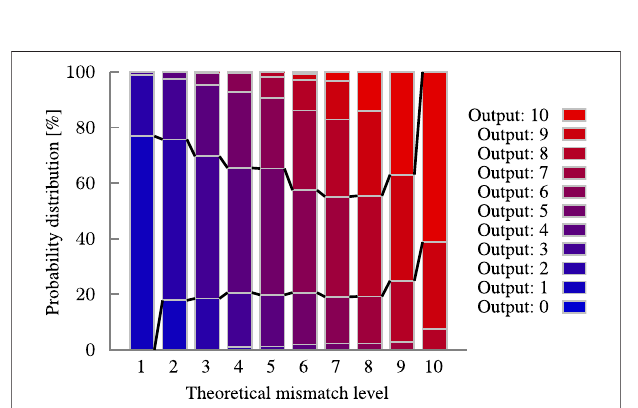
FIGURE 9 | Probability distribution modeling the output of the synaptic comparatorforagiveninputunderprocessvariation. Thefunnel-likeshapeby the probability mass of the correct outputs is highlighted with the black lines. 10-bit block with a precision of 10 bit.